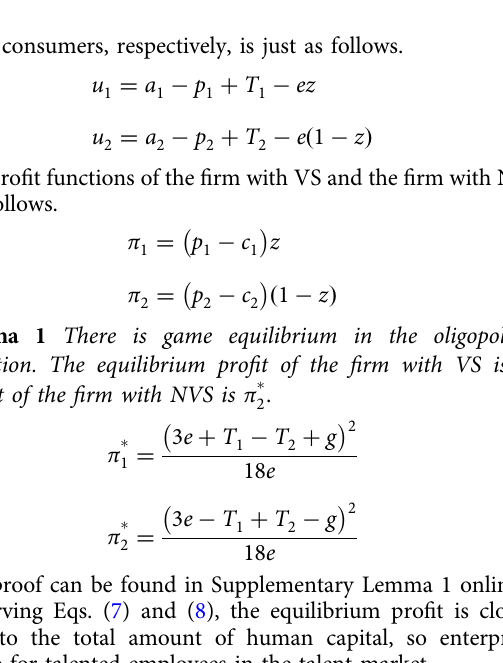
Fig. 3 Game competition structure. An enterprise will play games twice, one between the enterprise and other enterprises, and the other between the enterprise